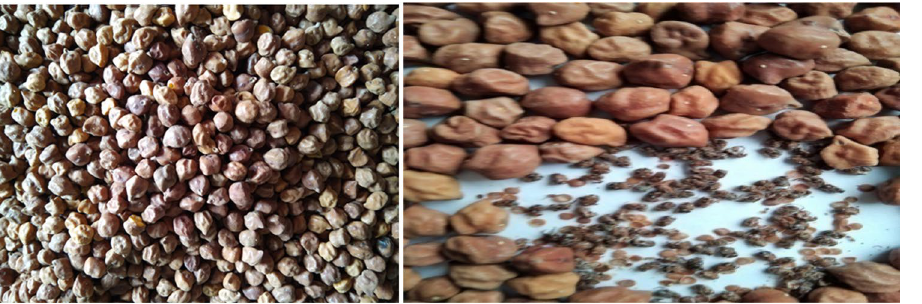
Figure 3. A look on chickpea food seed deterioration by